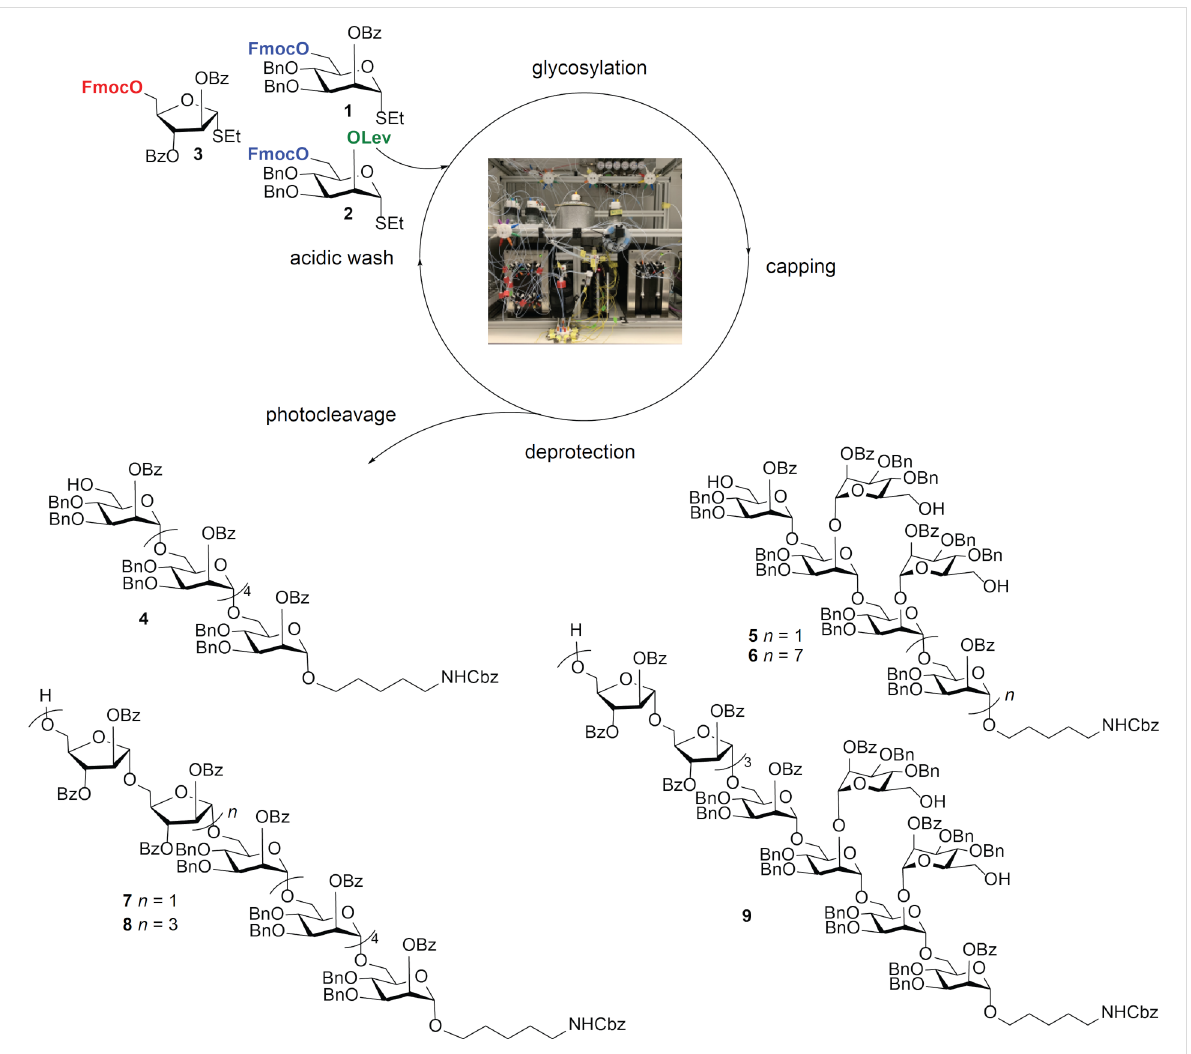
Scheme 1: Schematic representation of AGA for oligomannosides and oligoarabinomannosides using building blocks 1 – 3